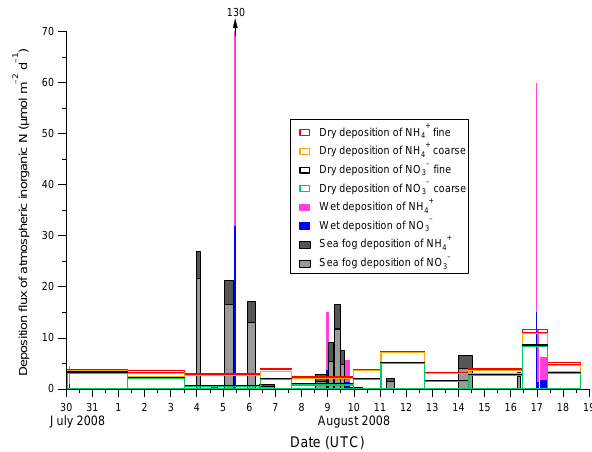
Figure 9. Temporal variations of dry, wet, and sea fog deposition fluxes for NH 4+ and NO 3– 2 Fig. 9. Temporal variations of dry, wet, and sea fog deposition fluxes over the subarctic western North Pacific Ocean during the cruise. 3 for NH + and NO − over the subarctic western North Pacific Ocean 4 3 during the